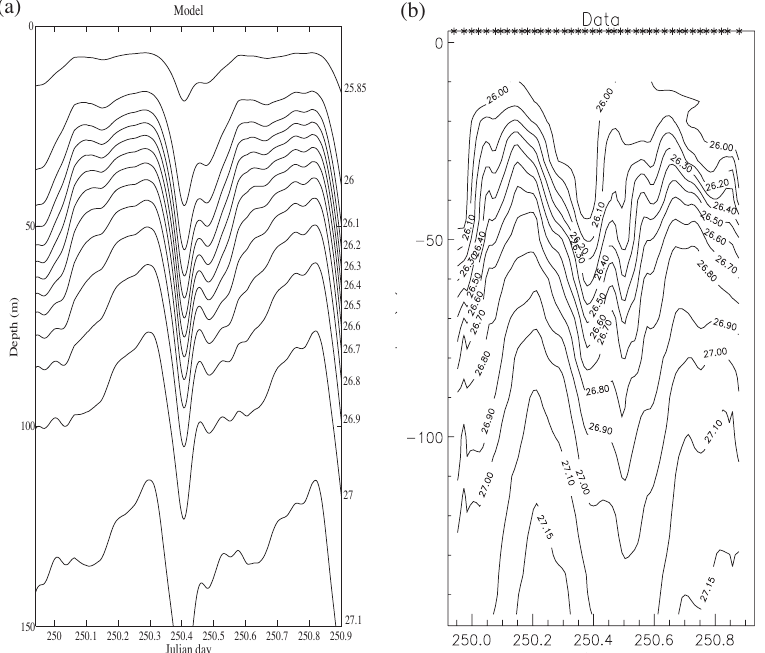
the near-bed layers, the predicted current (15 cm s -1 ) is slightly weaker than the measured current (20 cm s -1 ), which is an effect of the model viscosity. The time evolution of the east-west baroclinic component plotted in Figure 16 at the same location, PF06, confirms the previous result. In the data, there is an advance in phase of the velocity in the near-bed layers compared to the velocity in the near-surface layers. This is in agreement with the vertical distri- bution of the modelled current above the continental slope: the vertical current shear is due to the propa- gation of the different baroclinic modes, mainly the first one, which generates a phase difference across the ray characteristics (see Fig. 9c). Hence, at the same location, the time evolution of isopycnal interfaces in the top layers and the vertical distribution of the internal tide amplitude and phase are plotted in Figures 17 and 18 respectively . As in the velocity evolution, the model results are nearly in phase with the data: by comparing model and data trough locations in Figure 17, the phase lag is 0.1 day (i.e. 2 h). Between 400 and 1000 m depth the mod- elled vertical phase variation is in good agreement with the data: the advance in phase of the internal tide in the layers at 1000 m compared with the layers at 400 m is confirmed. The amplitude of the internal tide is of same order of magnitude (50 m) in the data and in the model results. Furthermore, the vertical